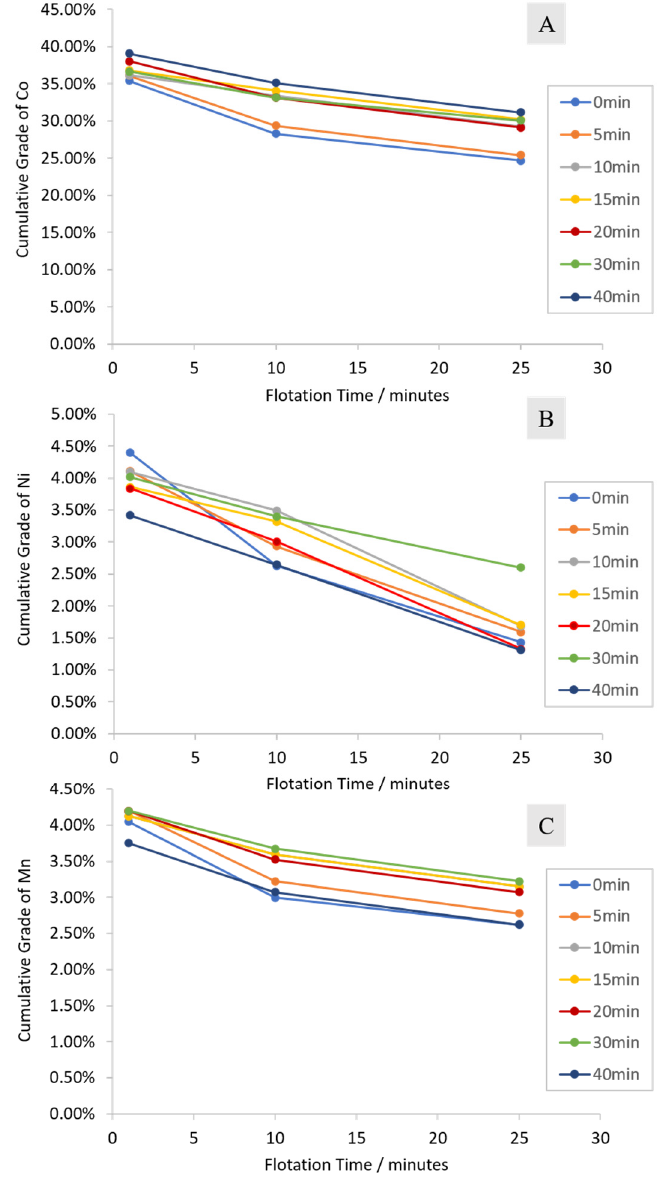
Figure 7. The cumulative grades of selected metals ( A ) Co, ( B ) Ni, and ( C ) Mn from cathode active materials in waste LIB after various milling times.